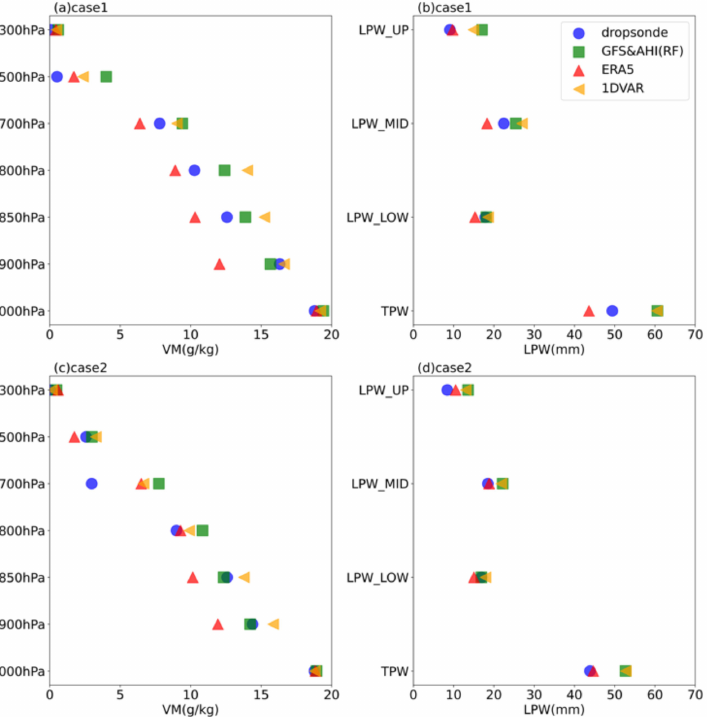
Figure 5. The multilayer VM and LPW retrievals or observations at 300 hPa to 1000 hPa from the RF-based algorithm (green square), the dropsonde (blue circle), the ERA5 (red triangle), and the 1DVAR algorithm (yellow